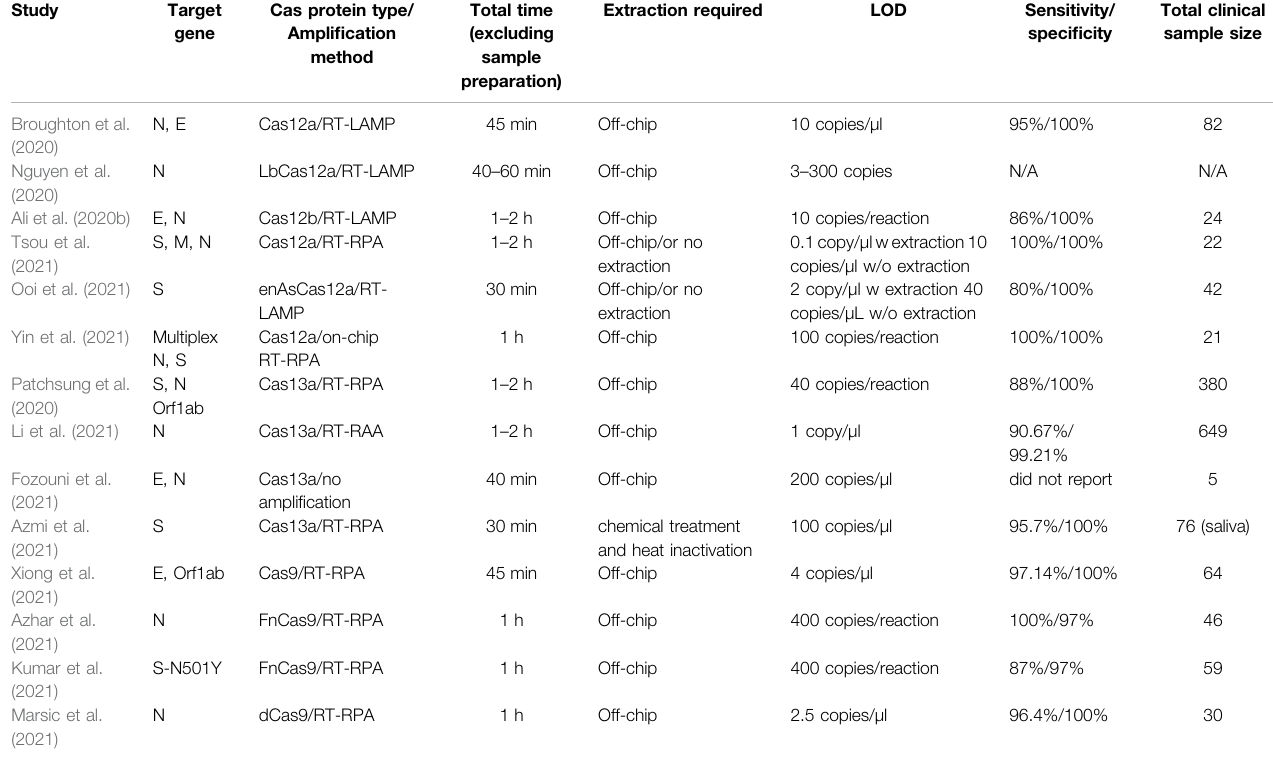
TABLE 3 | Existing paper-based CRISPR/Cas